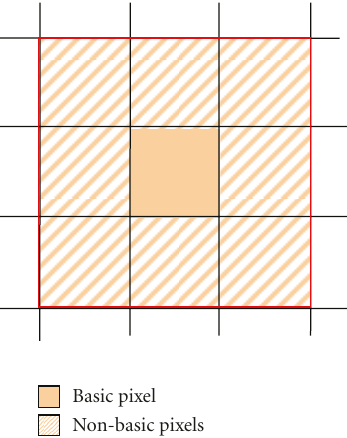
Figure 2: The layout of basic pixel and nonbasic pixel for a 3 × 3